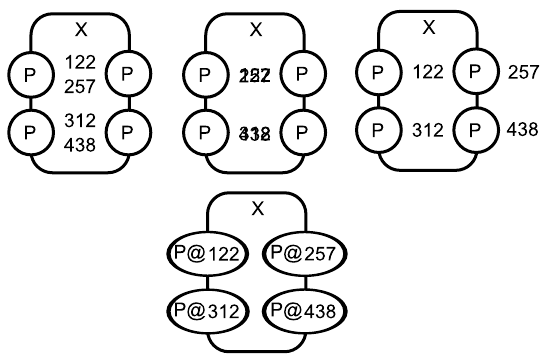
Figure 2.4: (Upper part) Examples of incorrect state variables . (Lower part) Correct